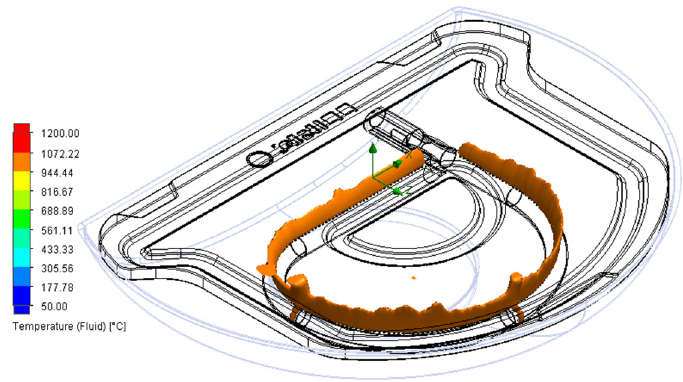
Figure 9. Combustion simulation results of improved design #1.